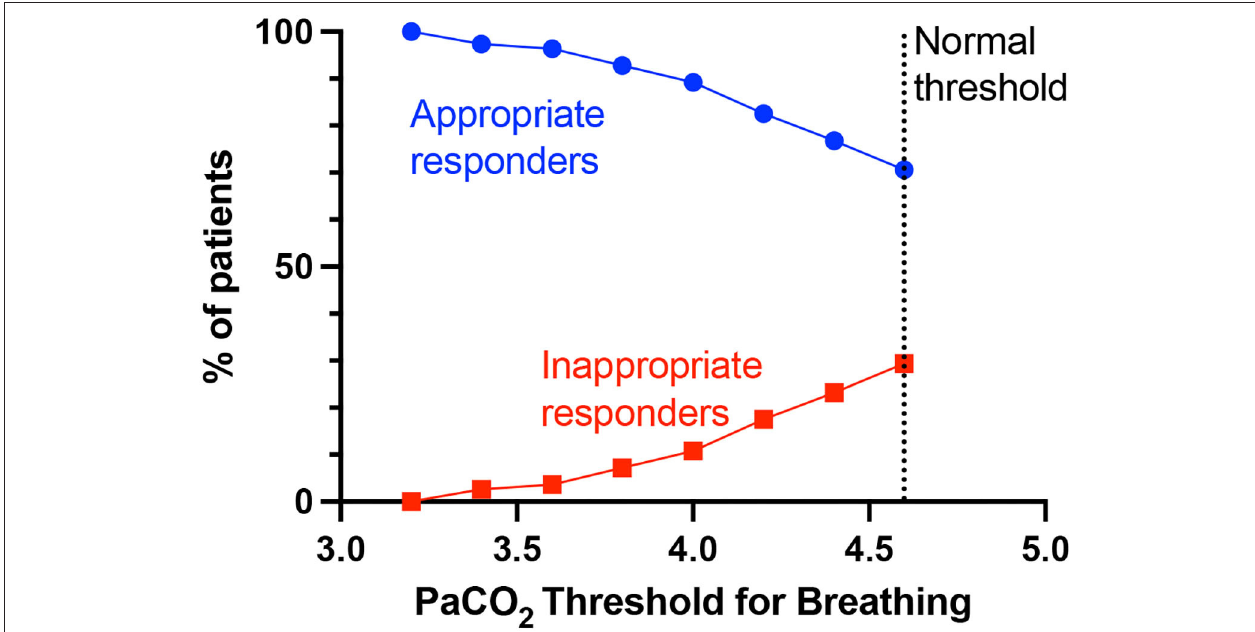
FIGURE 4 | PaCO 2 thresholds for breathing and % appropriate and inappropriate responders. The normal PaCO 2 threshold for breathing is > 4.6 kPa, below which PaCO 2 as a breathing drive would be suppressed. Lowering the PaCO 2 threshold (set-point) for breathing, will decrease the proportion of patients who are considered inappropriate responders for that particular PaCO 2 threshold i.e., still simultaneously have tachypnoea (RR > 20) and alkalosis (pH >